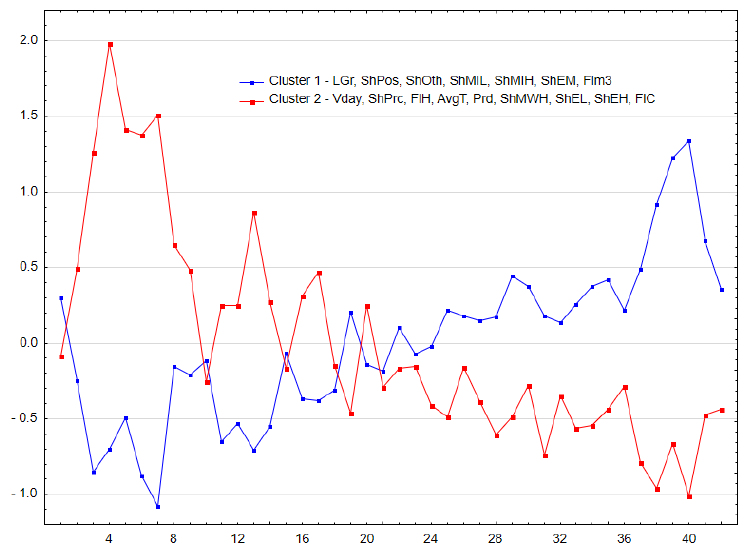
Figure 5. K-means separation of variables into clusters and their prevalence in consecutive workdays for machine A.